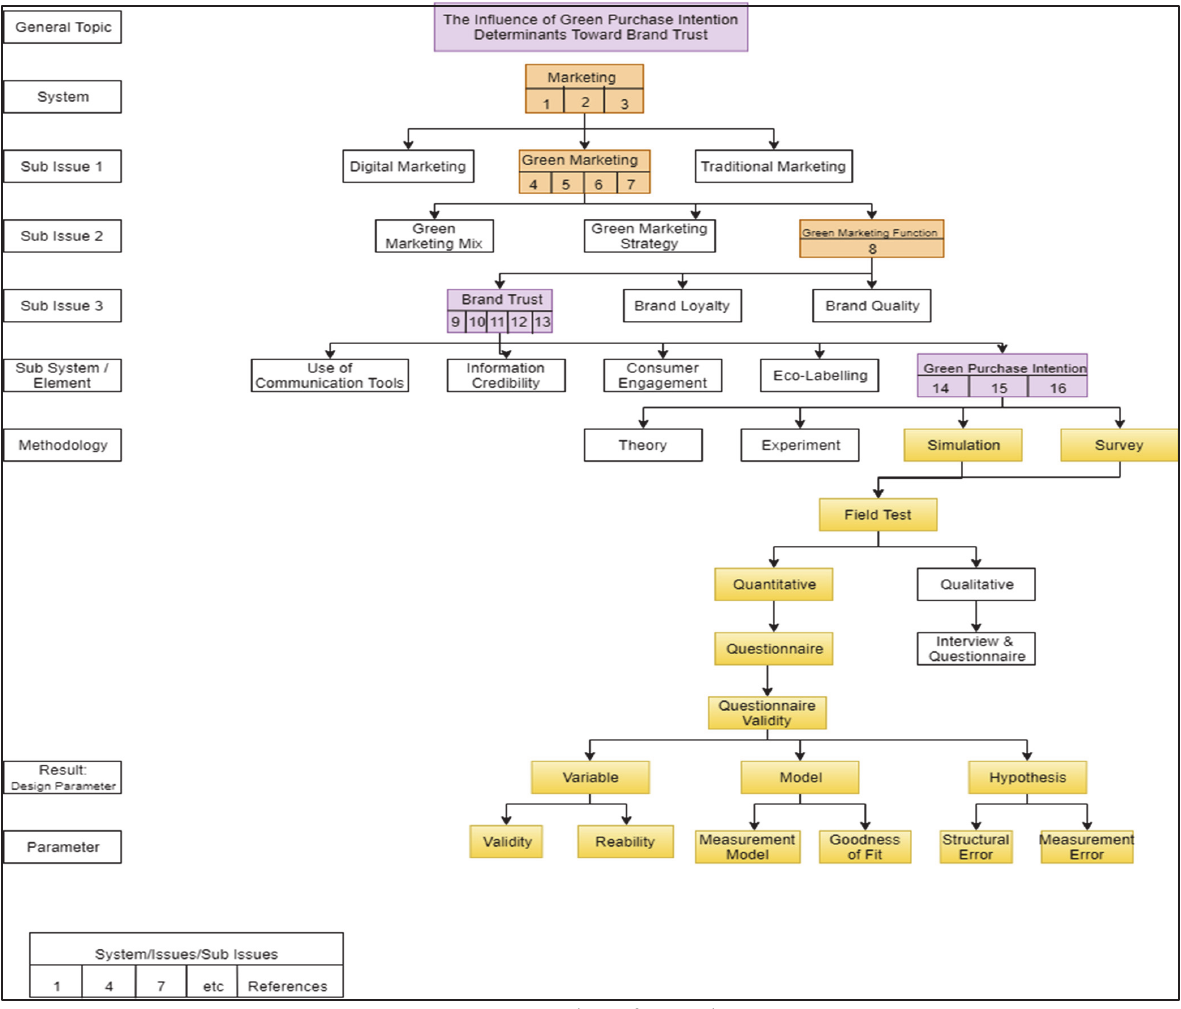
Fig. 1. CK-Chart of